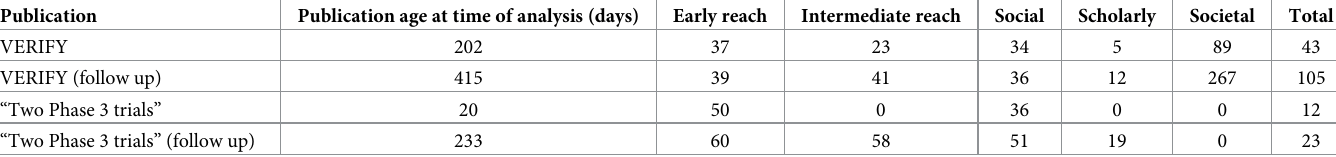
Table 6. EMPIRE Index scores for the two case example publications and time of initial analysis and subsequent